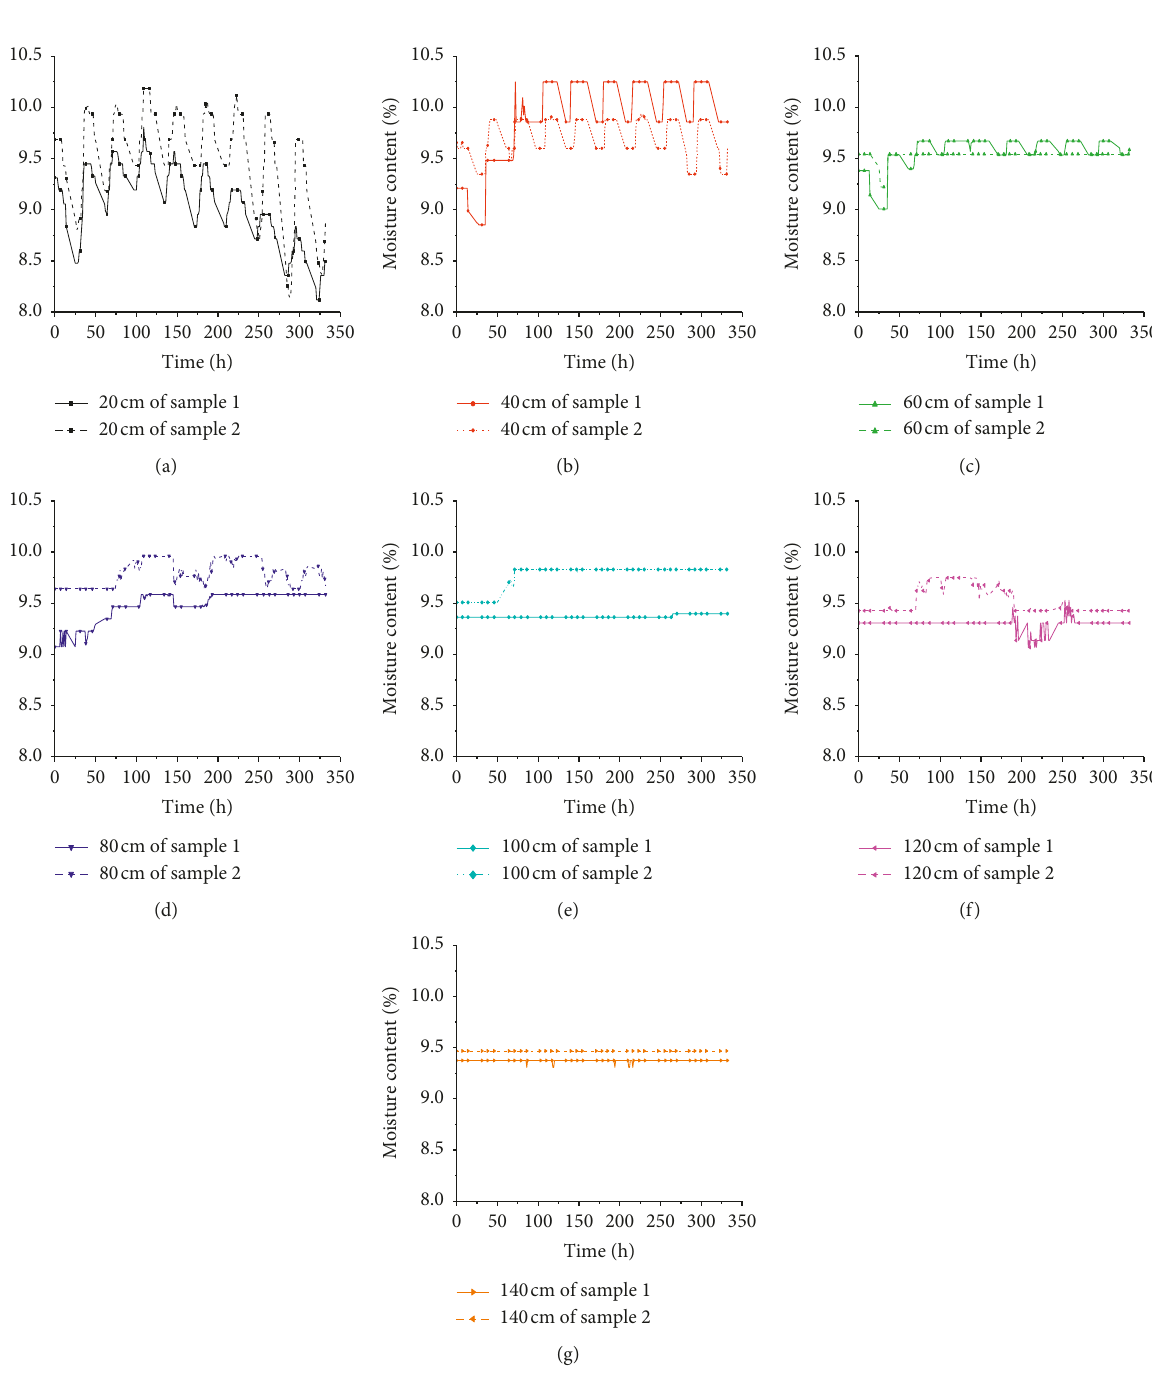
Figure 13: Curves of the moisture content with time for sample 1 of 1.5% salt content and sample 2 of 3% salt